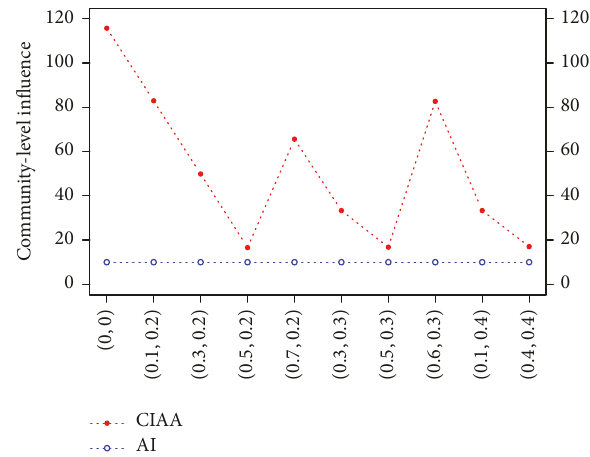
Figure 7: The community-level influence by two measuring algo- rithms with different ( 𝜏, 𝜌 )